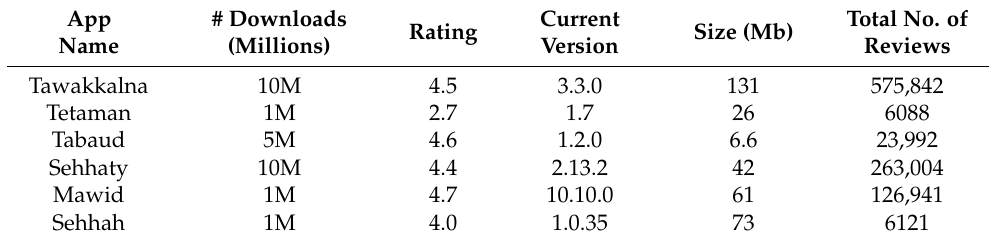
Table 2. Google Play Store metadata of mobile apps.